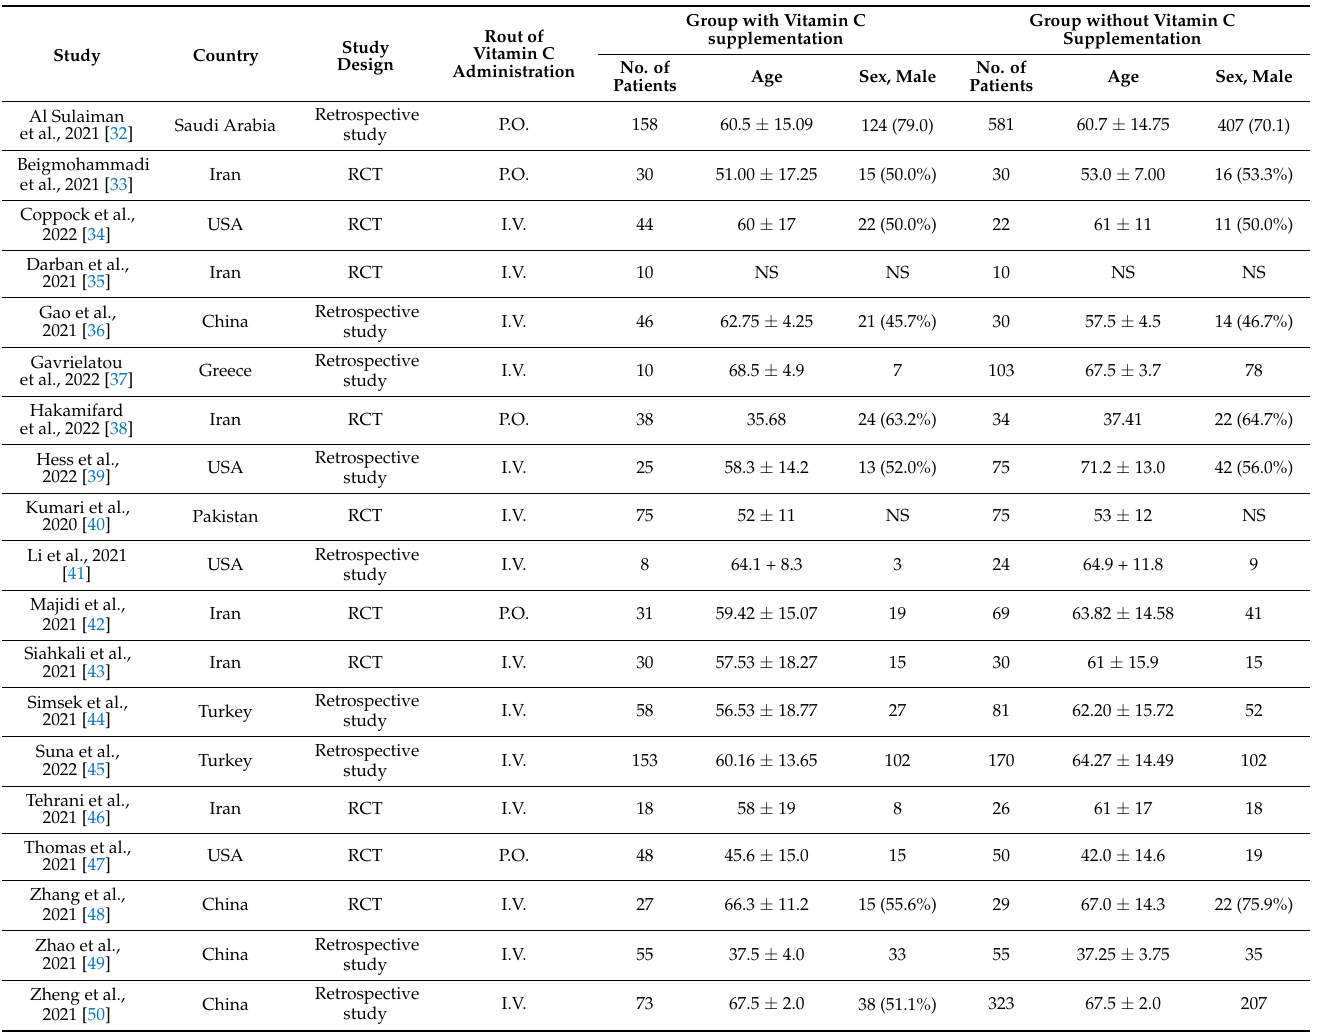
Table 1. Characteristics of included